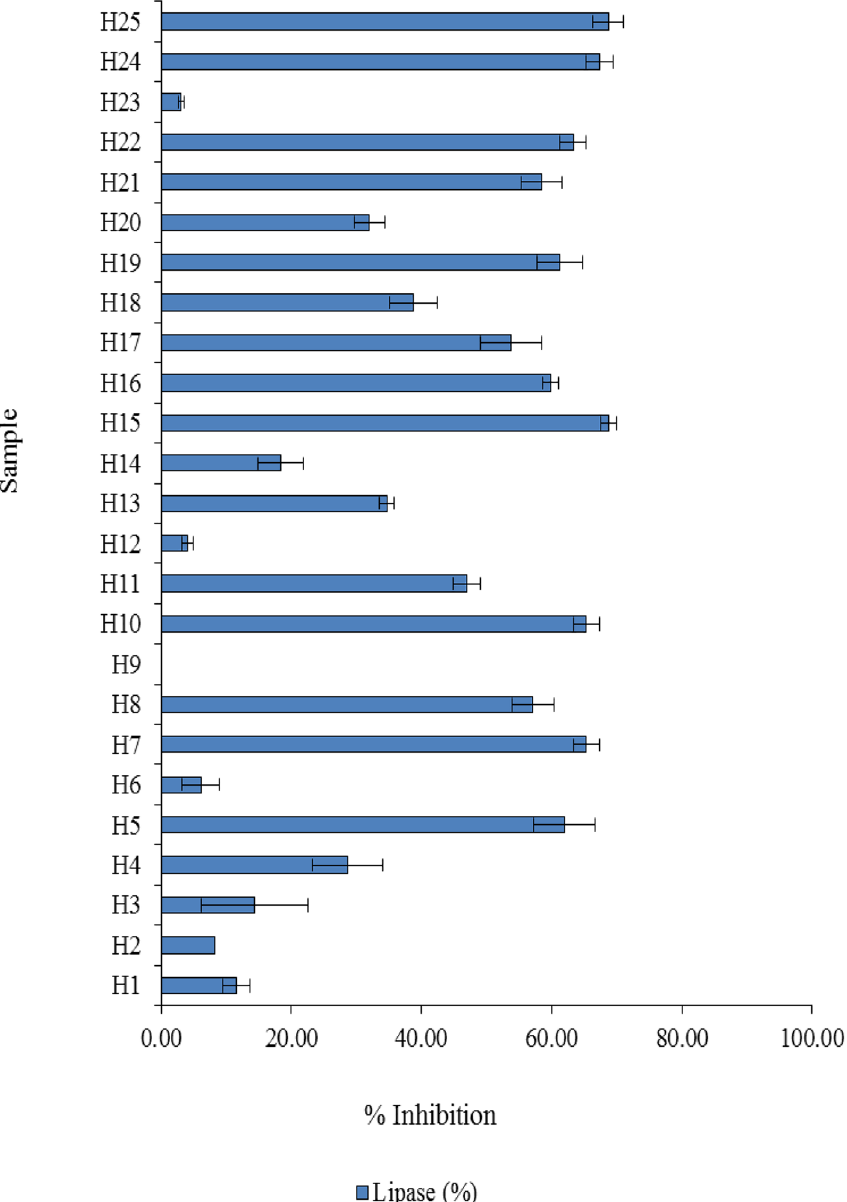
Figure 3. In vitro lipase inhibition of herbal tea